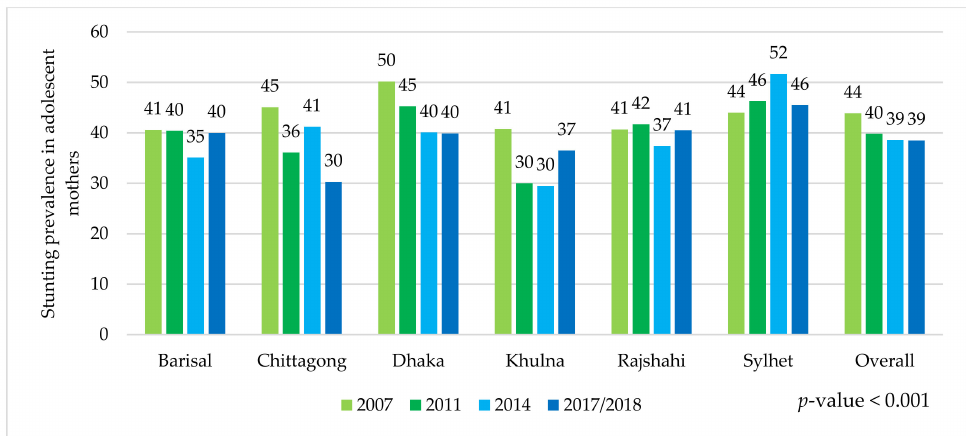
Figure 1. Stunting prevalence in adolescent mothers stratified by geographical region and round of the BDHS